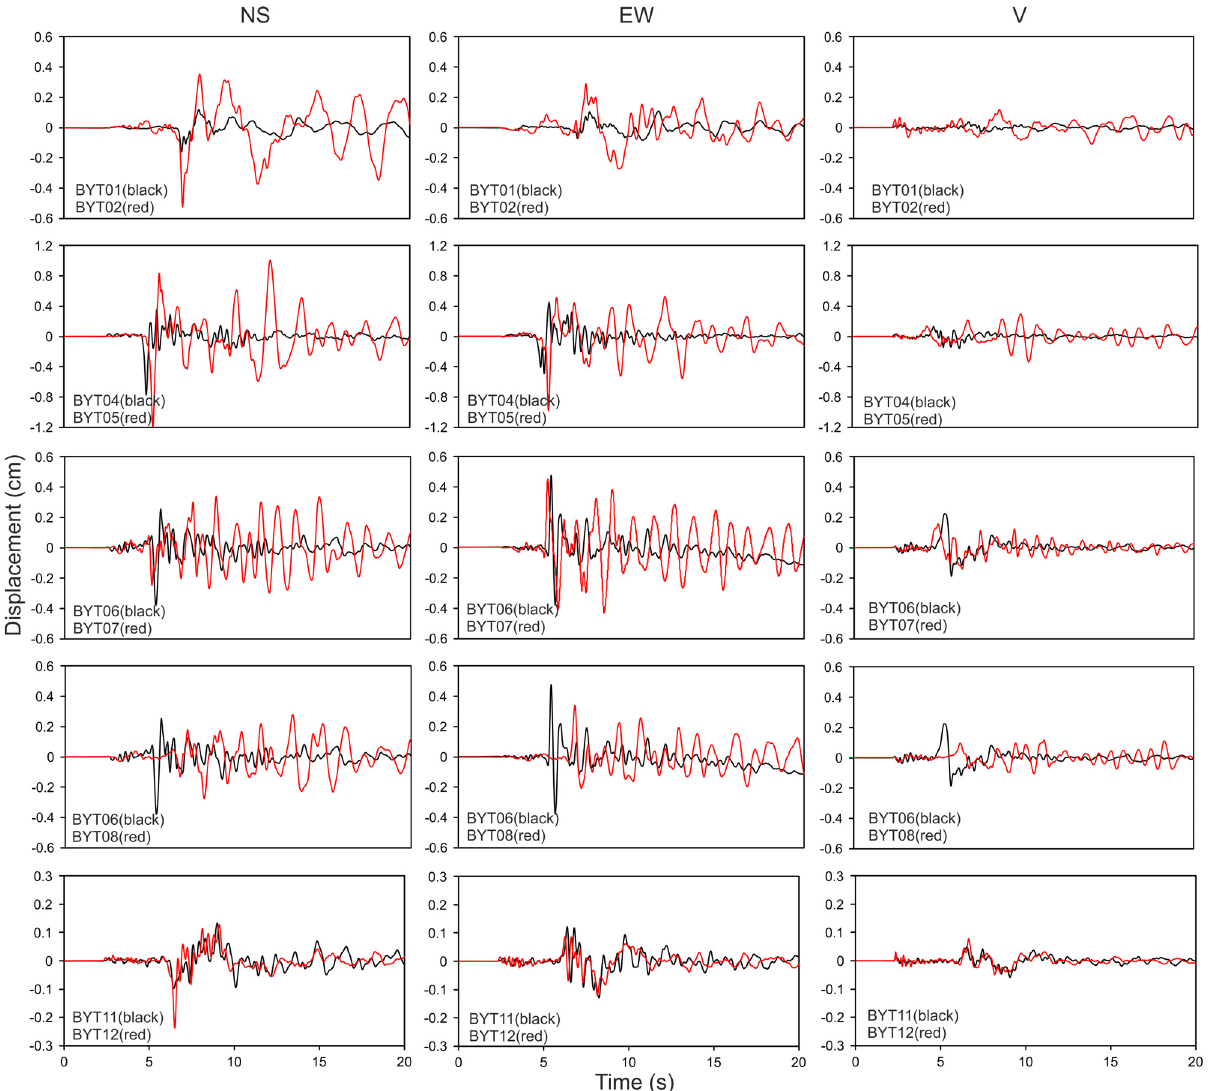
Figure 6. Displacement records of Gemlik earthquake are compared between the station couples. All records start 2 sec before the P arrivals. The red line records represent the stations located within basin, while the black line records represent the stations located on ridge, except for the couple of BYT11-BYT12 which both is located on